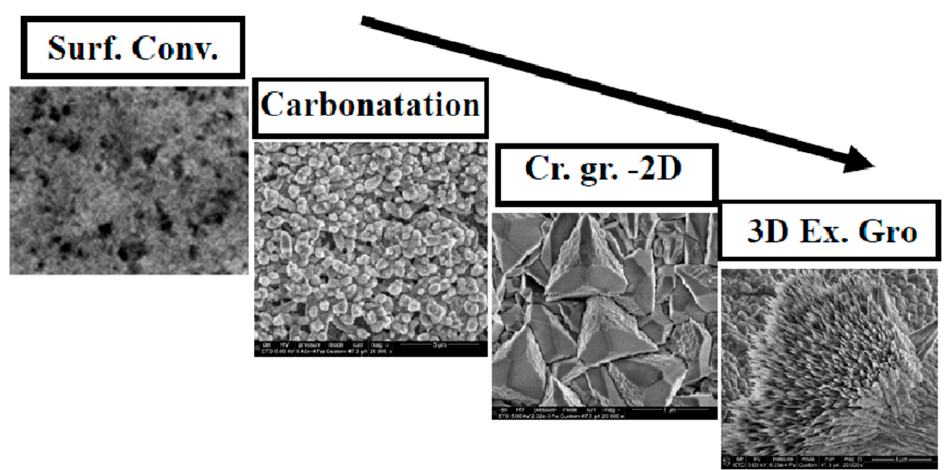
Figure 14. Flux diagram illustrating the identified stages of carbonate